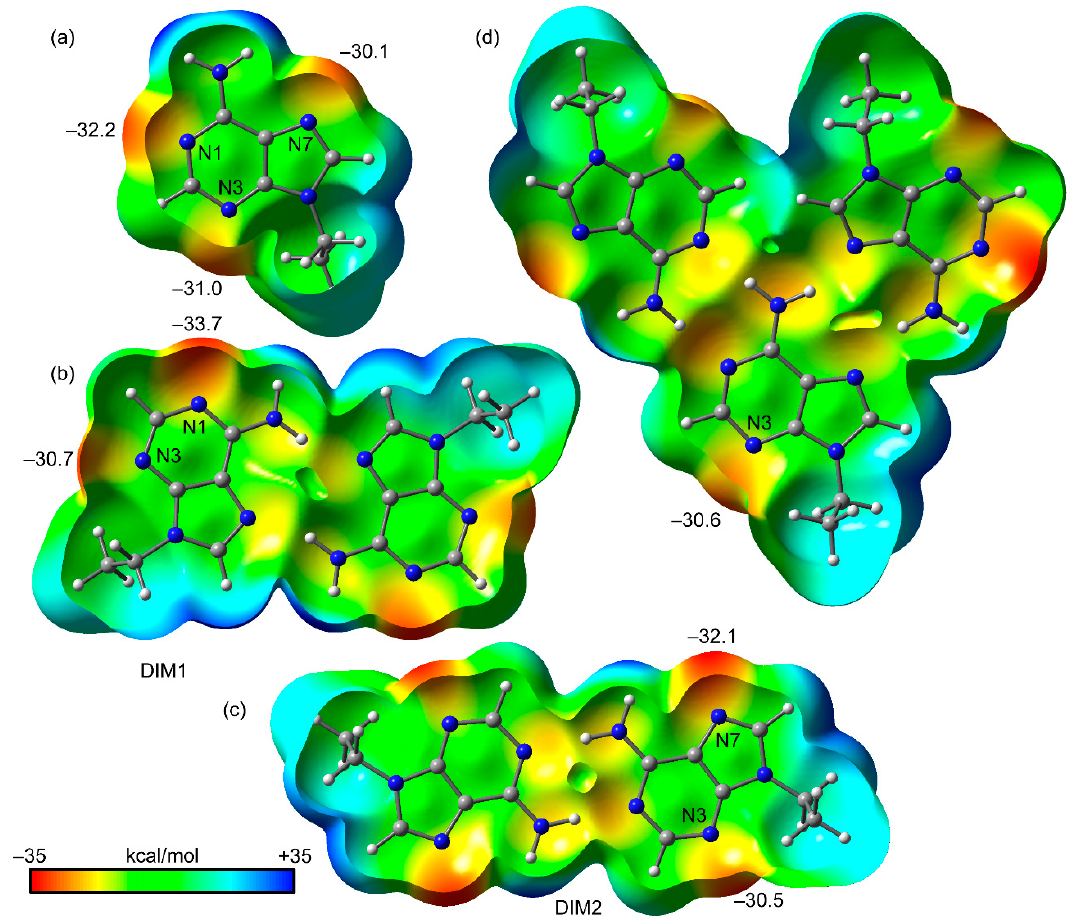
Figure 5. Open molecular electrostatic potential (MEP) surfaces (0.001 a.u. isosurface) of N 9 - ethyladenine (a), DIM1 (b), DIM2 (c), and the trimer (d). The MEP values at selected points of the surface are indicated in kcal/mol.